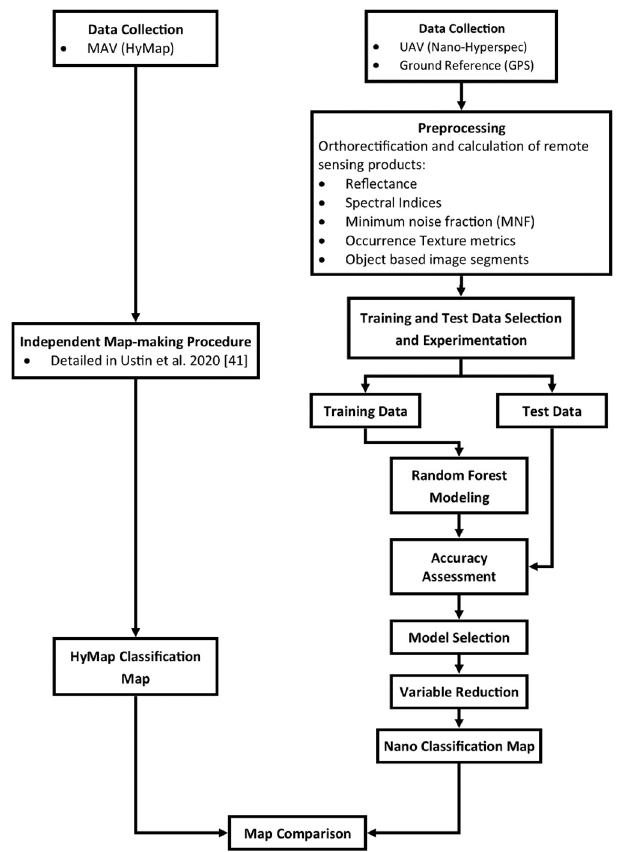
Figure 3. Project flow diagram outlining the classification and comparison process.